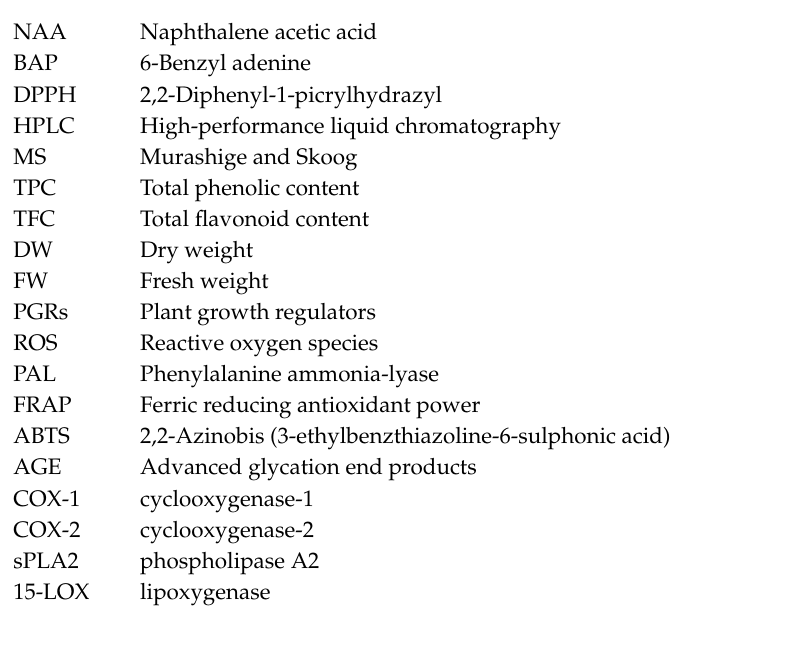
Supplementary Materials: The following are available online. Table S1: Actual values for PCC (Pearson Correlation Coe ffi cient) showing the relation between the main phytochemicals (TPC, TFC, ca ff eic acid, methyl-ca ff eate, scopoletin and esculetin) from extracts of in vitro culture of S. xanthocarpum subjected to di ff erent light treatments and the mentioned biological activities (antioxidant, anti-diabetes, anti-aging and